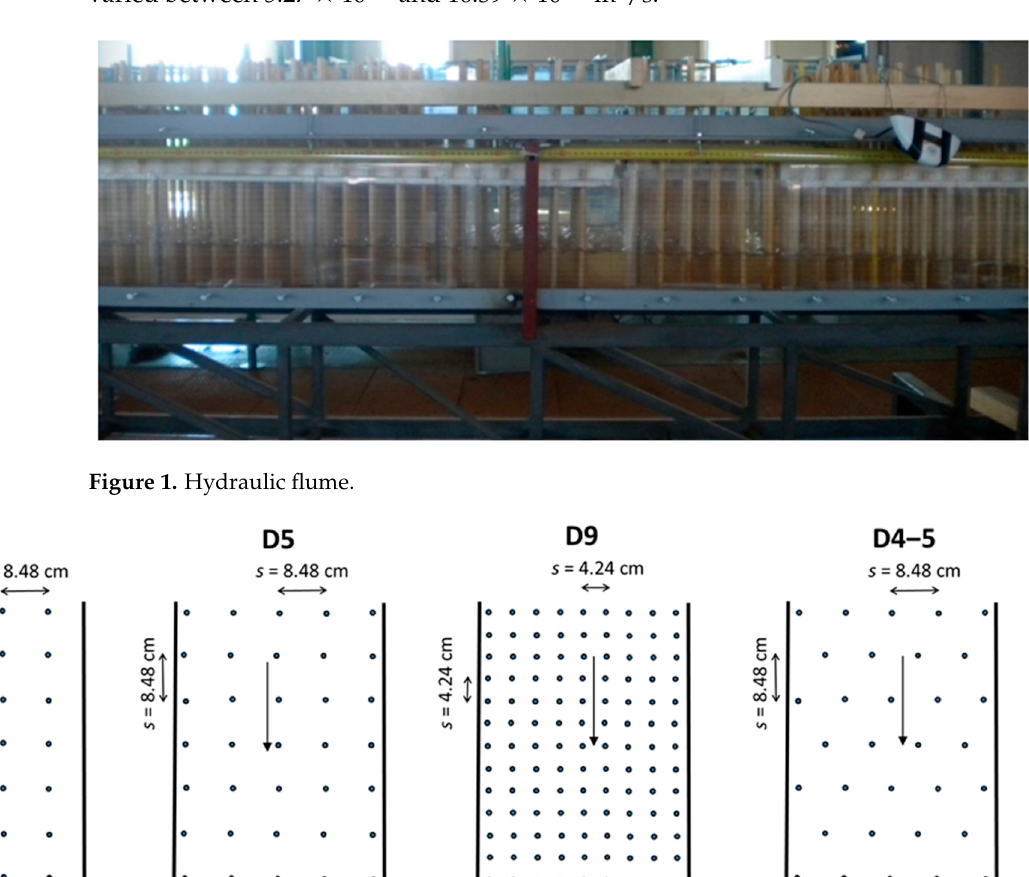
Figure 1. Hydraulic flume.